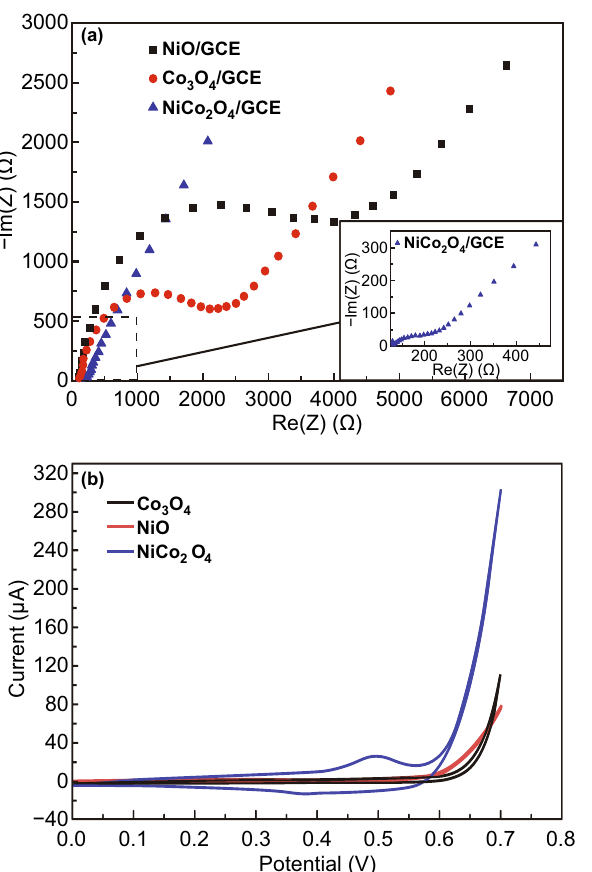
Fig. 24 a Electrocatalytic activities of MoS 2 -NiCo 2 O 4 /GCE in 0.1 M NaOH at a scan rate of 50 mV s −1 . b Amperometric response curves for MoS 2 -NiCo 2 O 4 /GCE. Reproduced with permission from Ref. [229]. Copyright © 2017 Elsevier